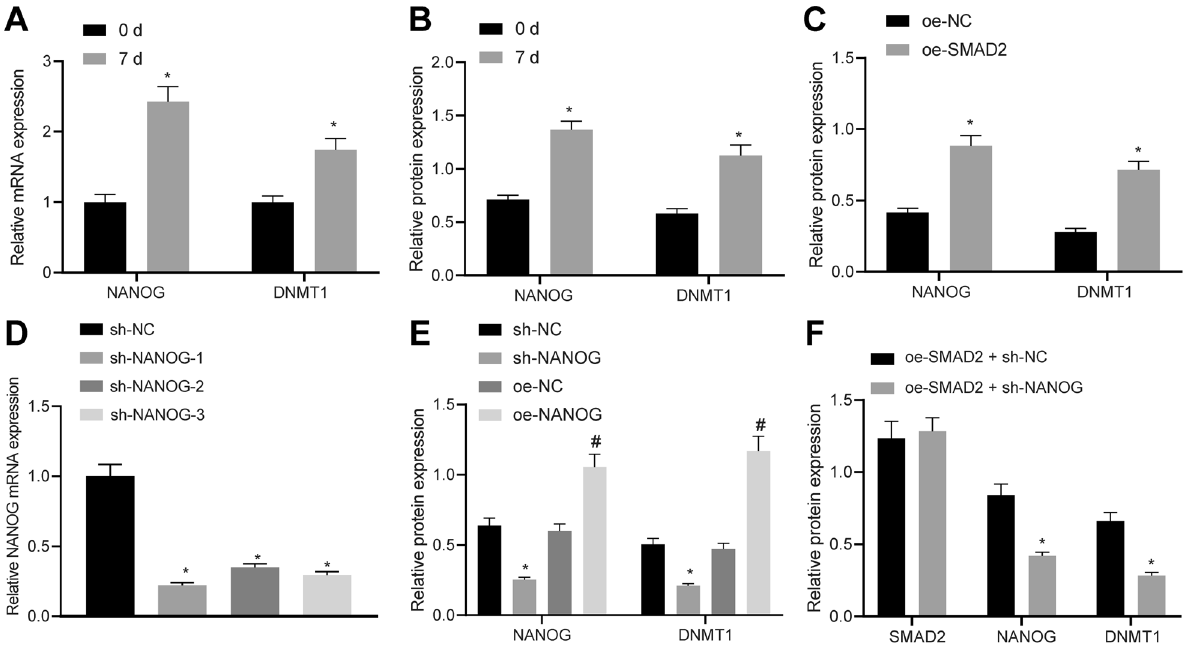
Fig. 4 SMAD2 upregulates NANOG to increase the transcriptional expression of DNMT1. NANOG and DNMT1 mRNA ( A ) and protein ( B ) levels in HFSCs after 7-day differentiation determined by RT-qPCR and western blot assay, with β -actin as internal reference, * p < 0.05 vs. day 0. C NANOG and DNMT1 protein levels in HFSCs after SMAD2 overexpression measured by western blot assay, with β -actin as internal reference, * p < 0.05 vs. oe-NC group. D Silencing ef fi ciency of 3 siRNAs targeting NANOG in HFSCs determined by RT-qPCR, with β -actin as internal reference, * p < 0.05 vs. sh-NC grou p . E NANOG and DNMT1 protein levels in HFSCs after overexpression or silencing of NANOG measured by western blot assay, with β -actin as internal reference, * p < 0.05 vs. sh-NC group; # p < 0.05 vs. oe-NC group. F SMAD2, NANOG and DNMT1 protein levels in HFSCs overexpressing SMAD2 determined by western blot assay, with β -actin as internal reference, * p < 0.05 vs. oe-SMAD2 + sh-NC group. Data are expressed as mean ± standard deviation. Data between multiple groups were compared by one-way ANOVA with Tukey ’ s post hoc test. Each cell experiment was repeated 3